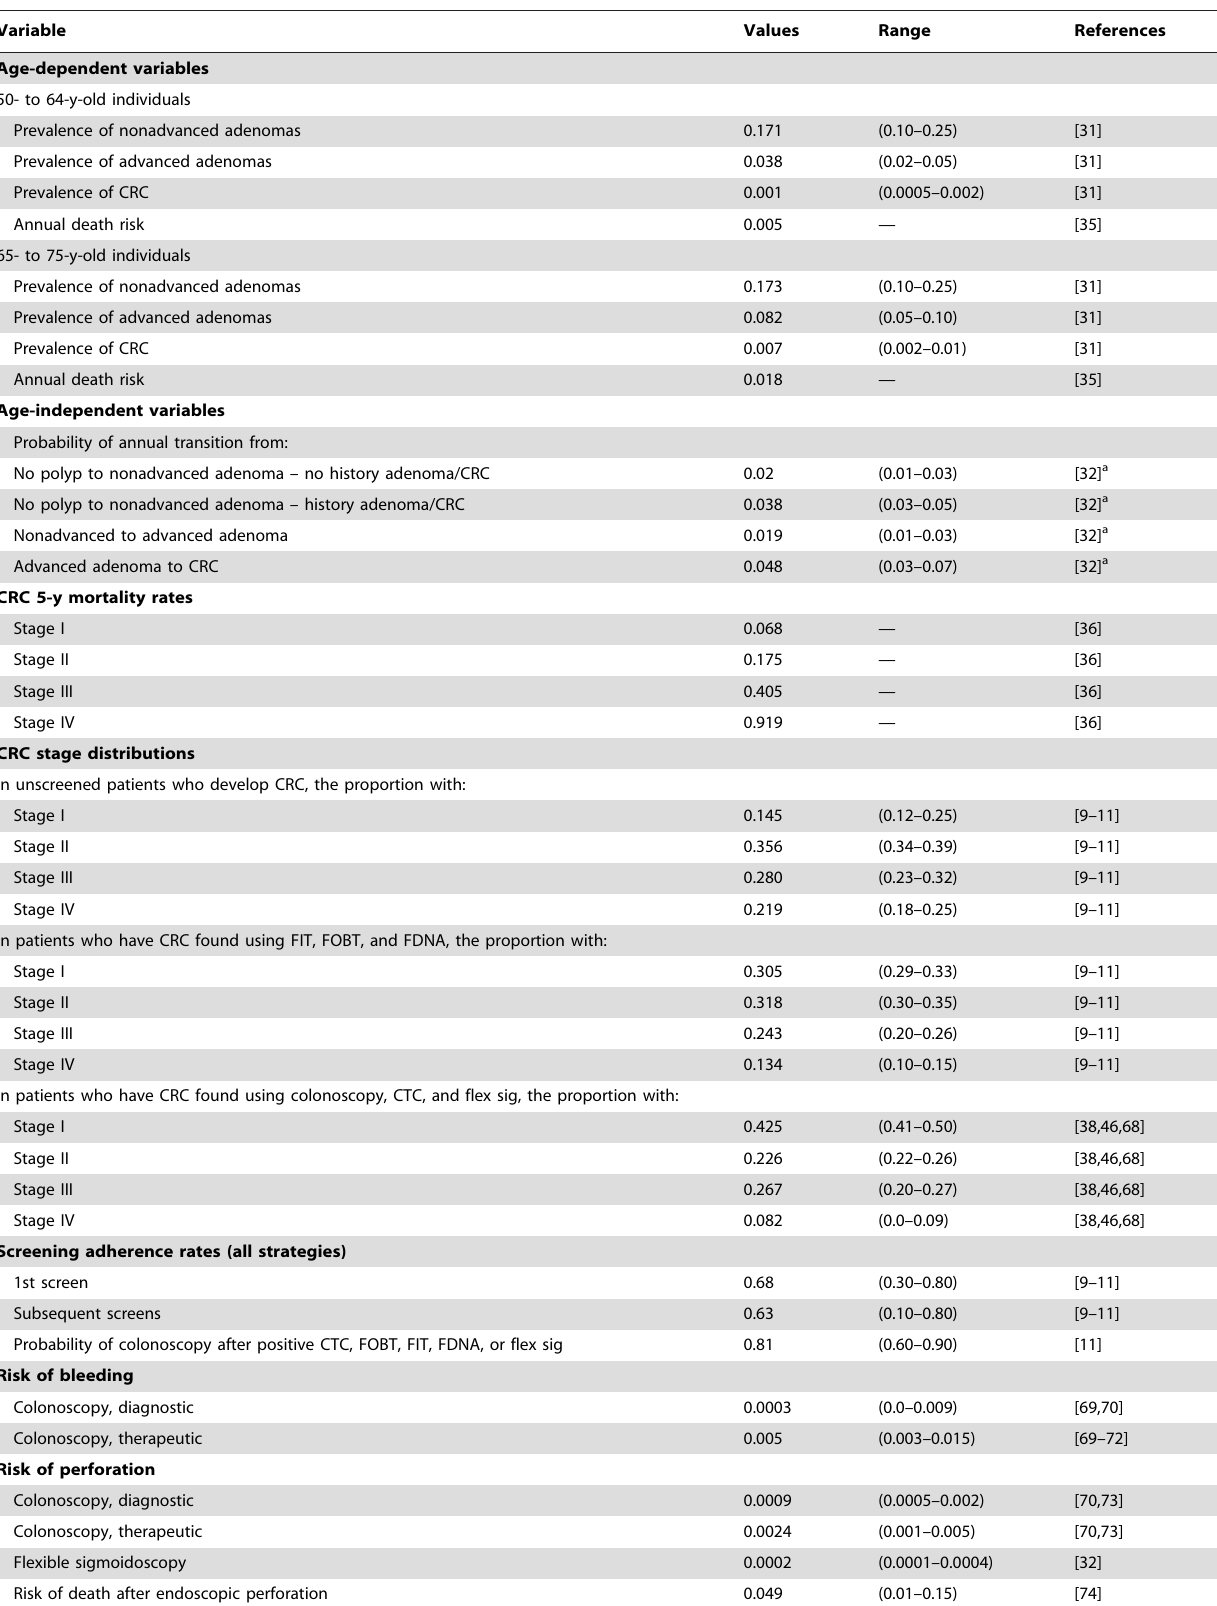
Table 1. Base case model inputs and ranges